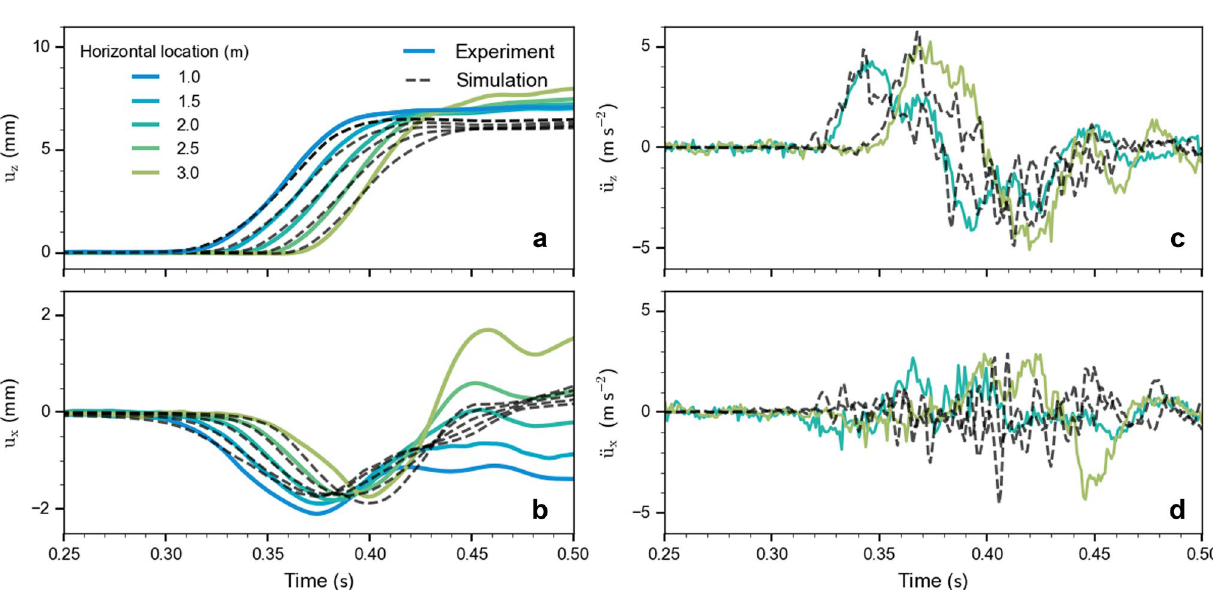
Figure 7. Comparison between observed and simulated displacements during PST experiment. ( a ) Temporal evolution of the normal displacement averaged over the height of the beam. ( b ) Temporal evolution of subsets of tangential displacements located at the top of the beam. ( c ) Temporal evolution of the normal acceleration. ( d ) Temporal evolution of the tangential acceleration. The colors represent the horizontal location and the black dashed lines the corresponding location for the simulated